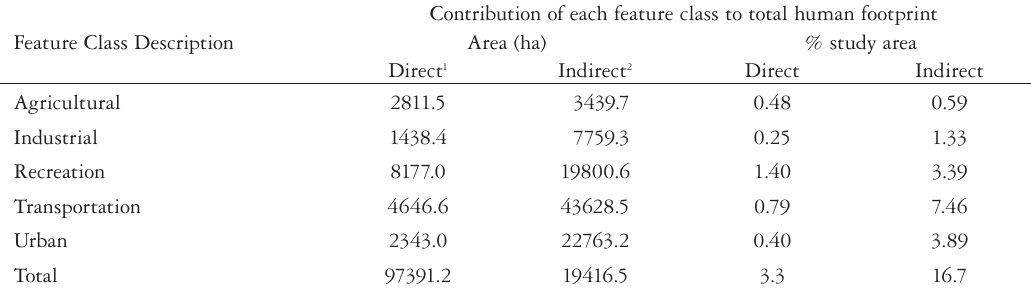
Table 3. Contribution of anthropogenic feature classes to the total human footprint within the Carcross caribou winter range. Feature Class